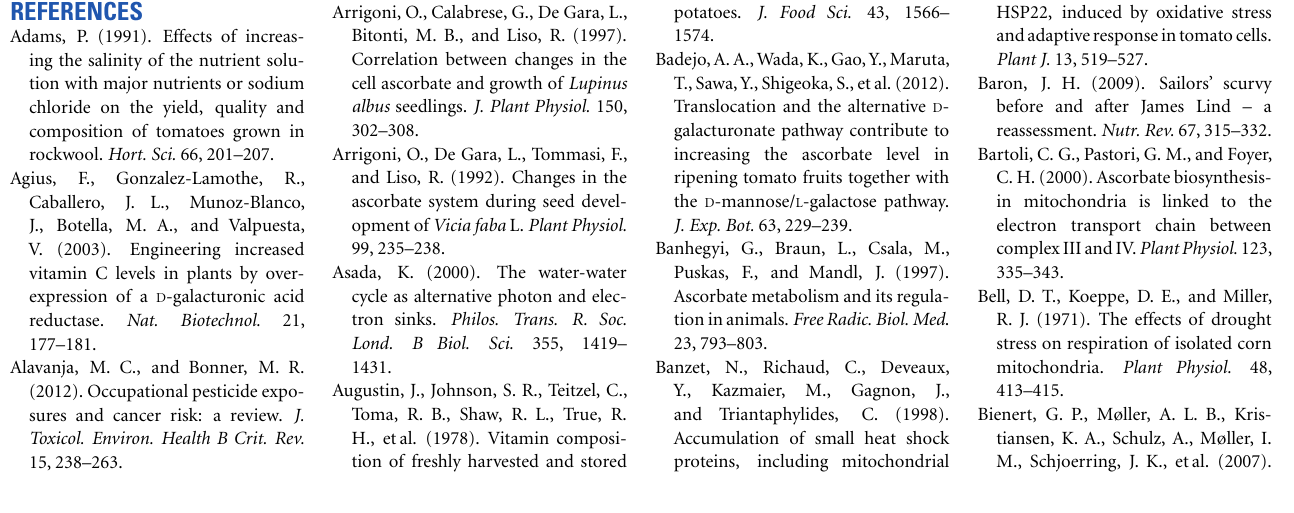
different, depending on several factors (see text for more details), a simplification of ASC changes over fruit maturation is given on the basis of data reported in Ioannidi etal., 2009 for tomato; Imai etal., 2009 for peach, Li etal., 2010a for